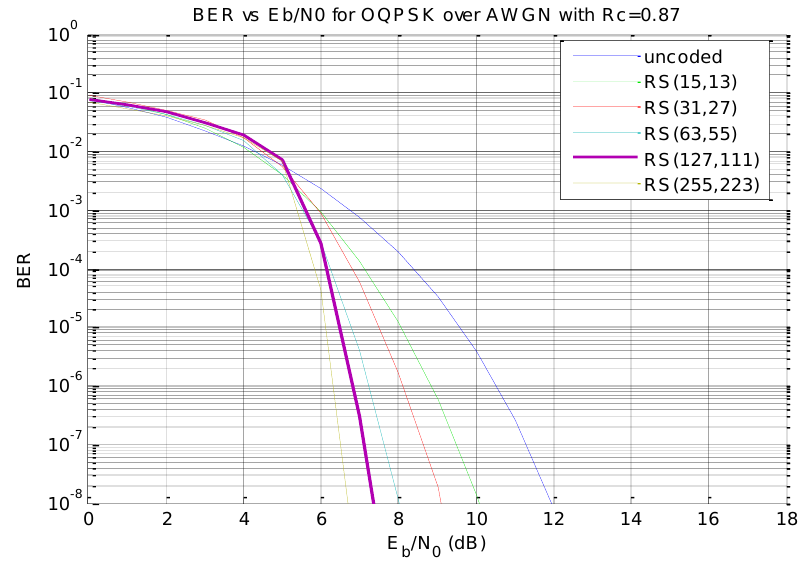
Figure 8. RS error performance for OQPSK over AWGN channel with constant R and increasing